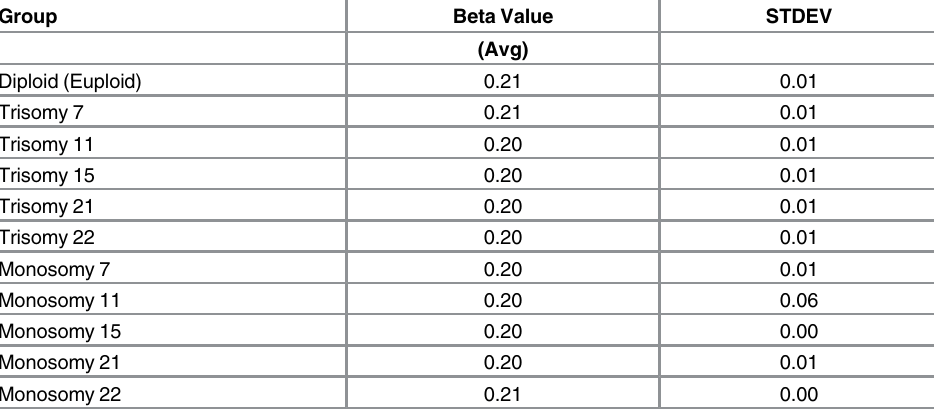
Table 3. Methylome profiles of pooled human blastocysts (n = 10 each pool with 2 – 3 replicates per group). Beta value reflects the level of global methylation with no variation observed in association with blas- tocyst chromosome constitution. (no statistical significance). Standard deviation (STDEV) was calculated for each group, reflecting low biological variability between